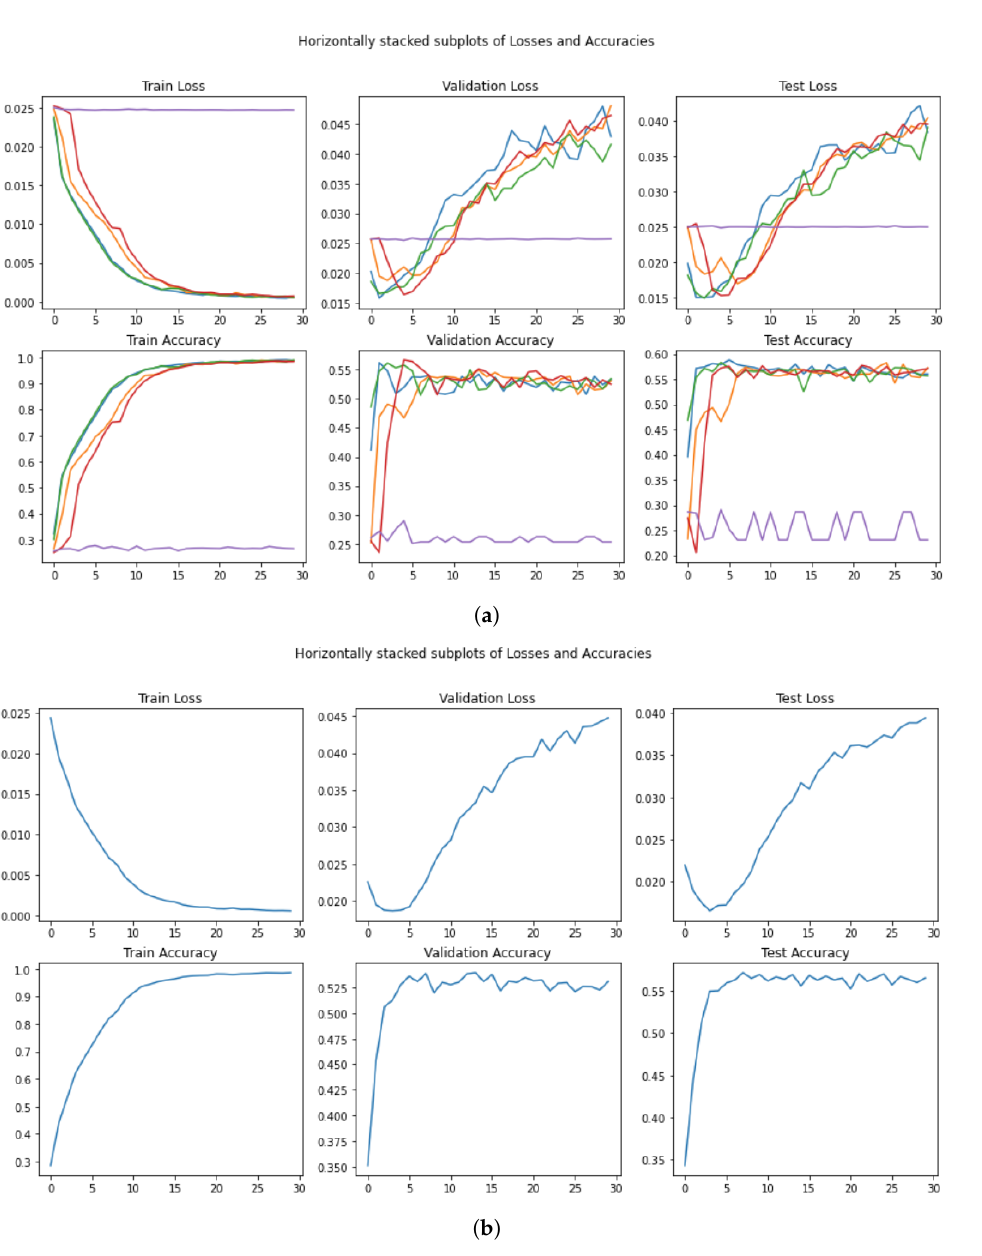
Figure 15. Performance in the training, validation, and test set for RoBERTa LARGE . ( a ) Loss and Accuracy per run and per epoch. ( b ) Mean loss and mean Accuracy per epoch after non-converging runs are